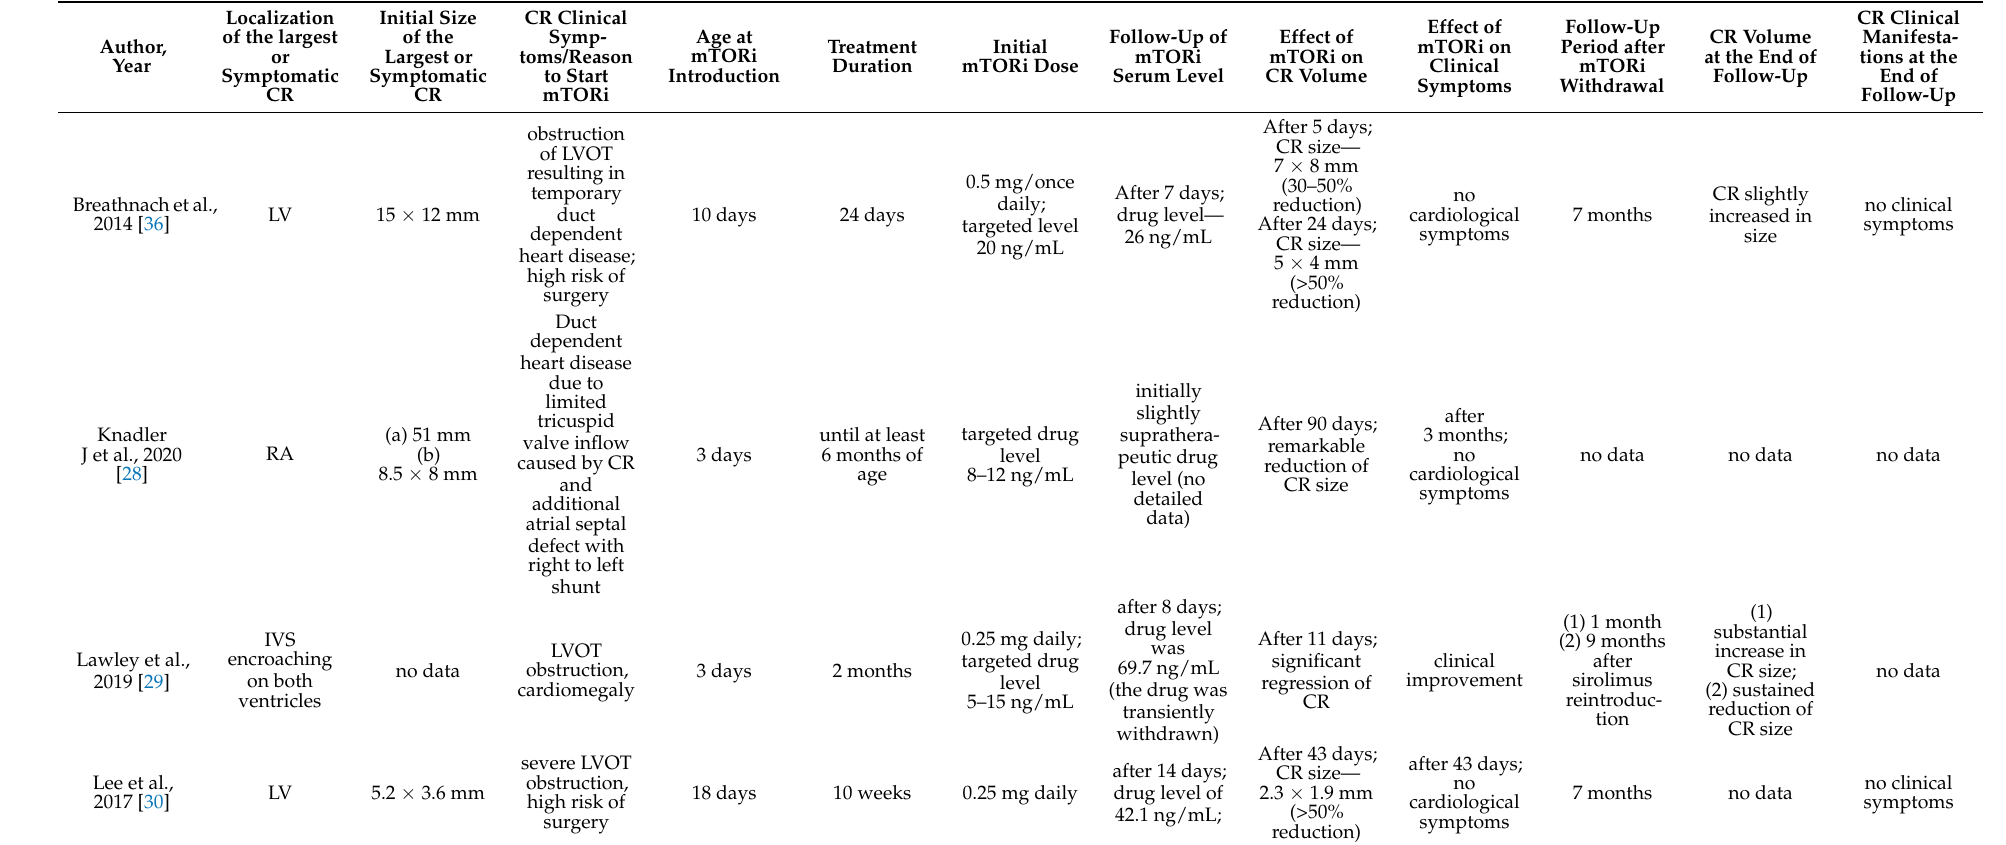
Table 2. Characteristics of children treated with